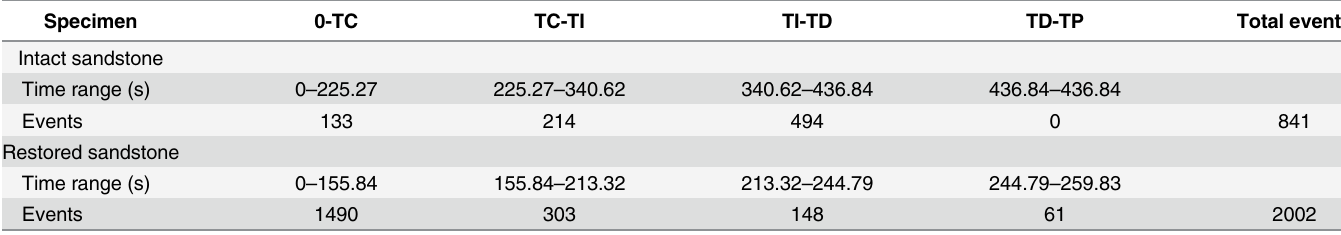
Table 3. Specific parameters for the damage source locations based on AE